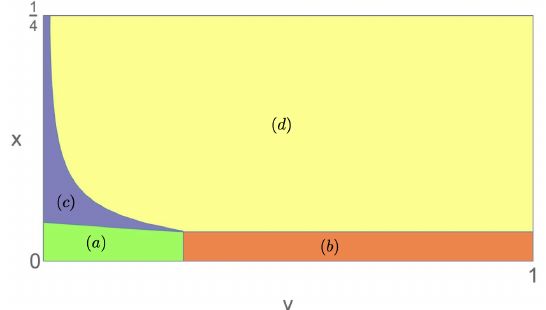
Figure 3 . The division of moduli space of the annulus with one bulk puncture into four regions corresponding to the four Feynman diagrams in figure 2. The green region describes the Feynman diagram in figure 2(a) and is given in (5.5). The red region describes the Feynman diagram in figure 2(b) and is given in (5.7). The blue region describes the Feynman diagram in figure 2(c) and is given in (5.9)–(5.11). The remaining yellow region describes the Feynman diagram in figure 2(d), and covers the bulk of the p v, x q moduli space. We have taken for the purposes of plotting this